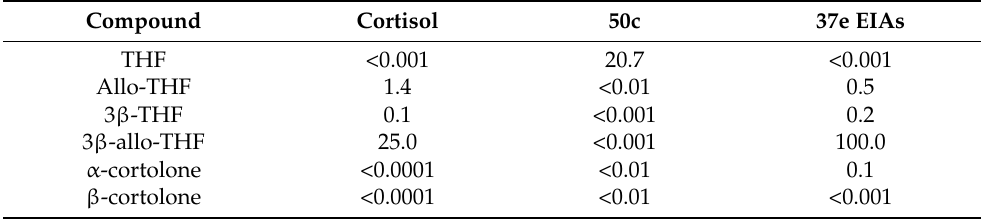
Figure 3. EIAs used for analyses of faecal extracts: ( a ) Cortisol EIA, ( b ) 37e EIA, and ( c ) 50c EIA. Red lines represent Pixie and black, Harvey. Table 3. Percentage cross-reactivity of several steroids with the three different EIAs. Cross-reactivity is relative to the respective standards (cortisol, tetrahydrocorticosterone for 50c, and 3 β ,5 α -tetrahydrocorticosterone for 37e).